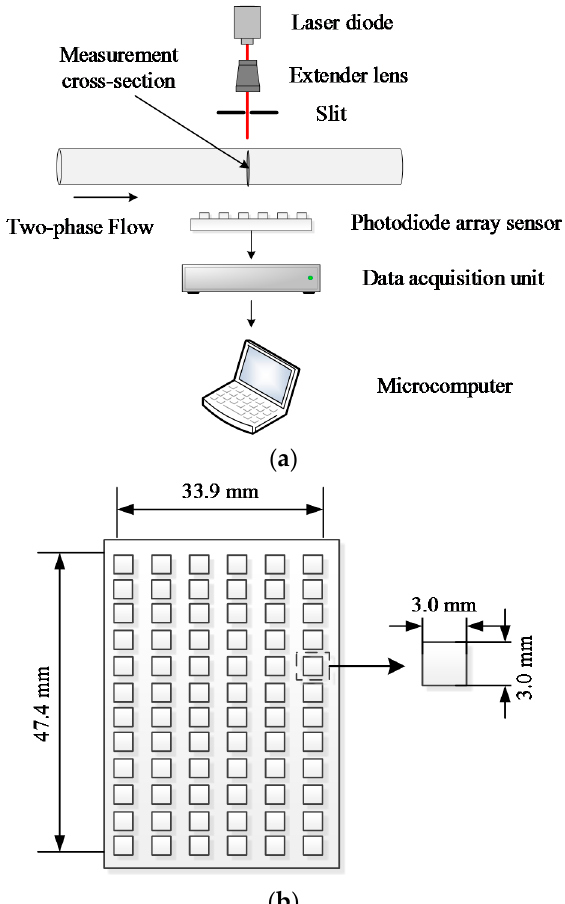
Figure 1. ( a ) The structure of the new void fraction optical measurement system; ( b ) The layout of the photodiode array sensor.